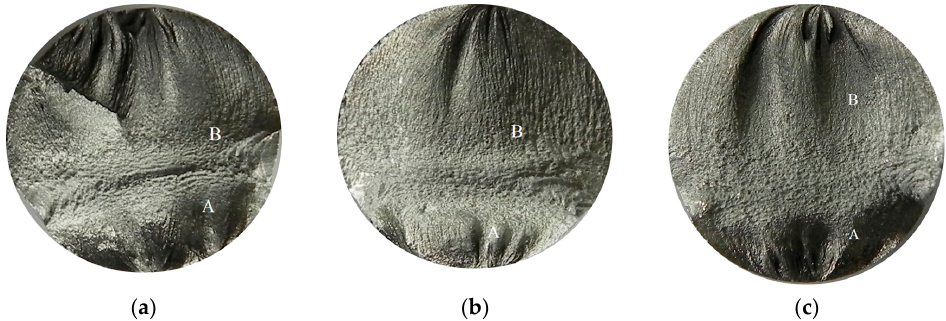
Figure 5. Fatigue fracture of an exemplary samples from a series subjected to the solution in demineralised water, submitted to stress amplitude σ a within a range from 217 to 227 MPa: ( a ) 7 days of immersion (Sample No. 2, Table 6); ( b ) 14 days of immersion (Sample No. 6, Table 7); ( c ) 28 days of immersion (Sample No. 4, Table 8). Cracks originated at the surface, from the bottom of the specimen, where: A — crack growth region, B — fast fracture zone.